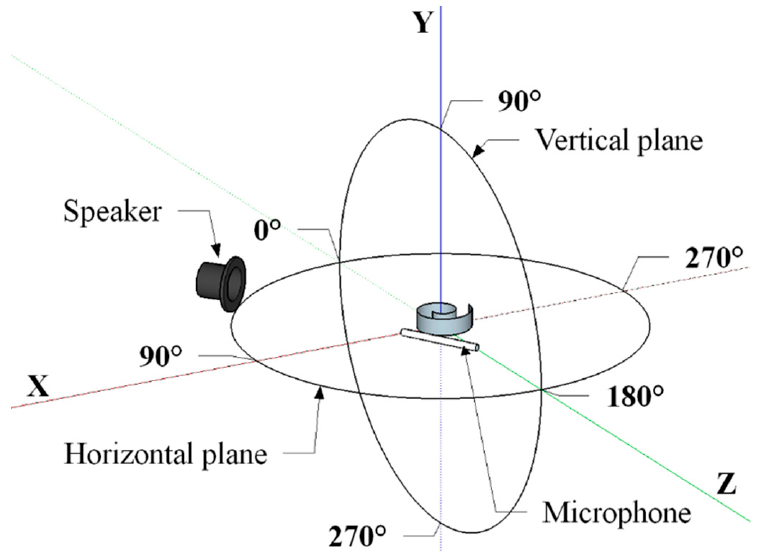
Figure 6. Experimental setup (not to scale) to measure the received radiation pattern in both the horizontal and vertical plane. The distance separating the speaker, which can be manually moved with 15° steps, and the US receiver, next to the microphone, was equal to 0.3 m.